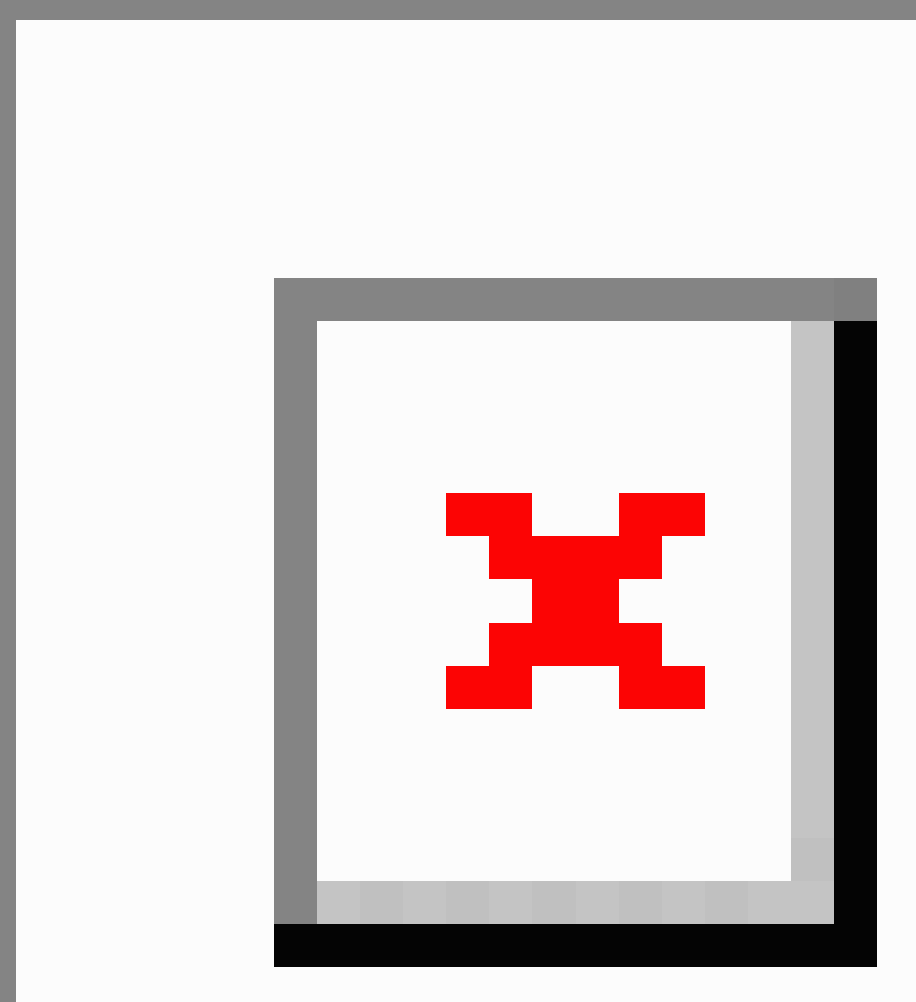
Figure 3. Screenshot of items regarding the pros and cons of alcohol